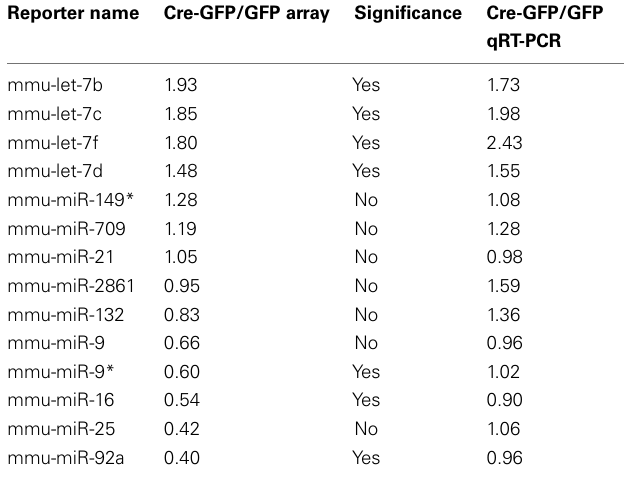
TableA3 |Validation of the miRNA array with qRT-PCR